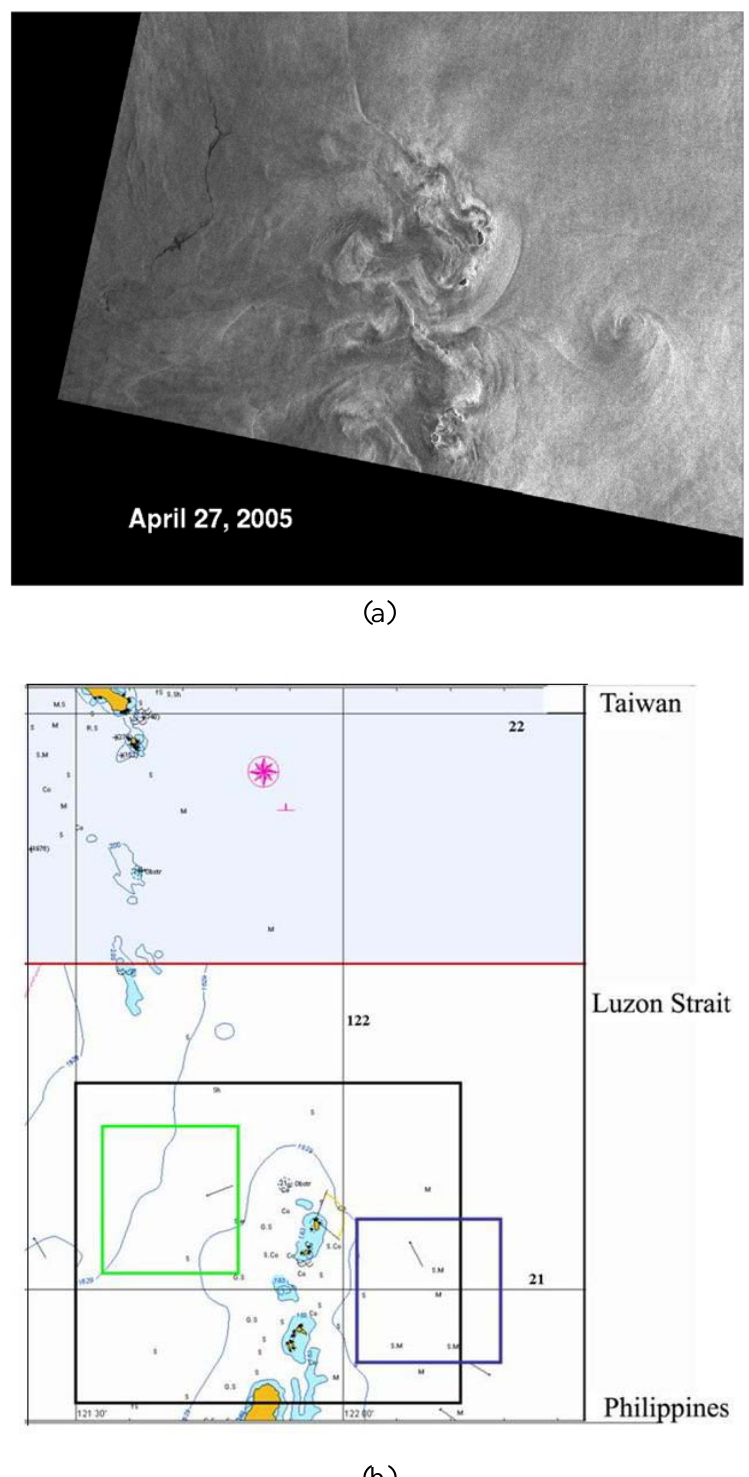
image as the mesoscale surface features. For deriving the ocean surface drift near the oil slick, a SAR subscene has been selected from each image. Figure 1. (a) ERS-2 SAR image (60 km × 80 km) collected on April 27, 2005, north of Philippines in the Luzon Strait, and (b) the location map with the SAR image coverage area shown in the large black box. The small boxes are subscenes coverage areas for surface slick and eddy tracking